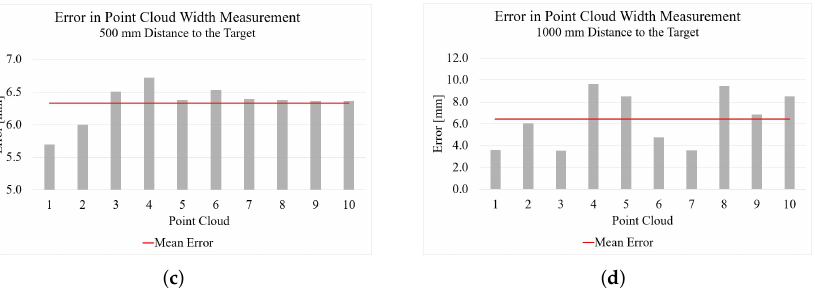
Figure 6. Results of the foot measurement with the Intel RealSense D455 SL camera: ( a ) length results from 500 mm; ( b ) length results from 1000 mm; ( c ) width results from 500 mm; ( d ) width results from 1000 mm.